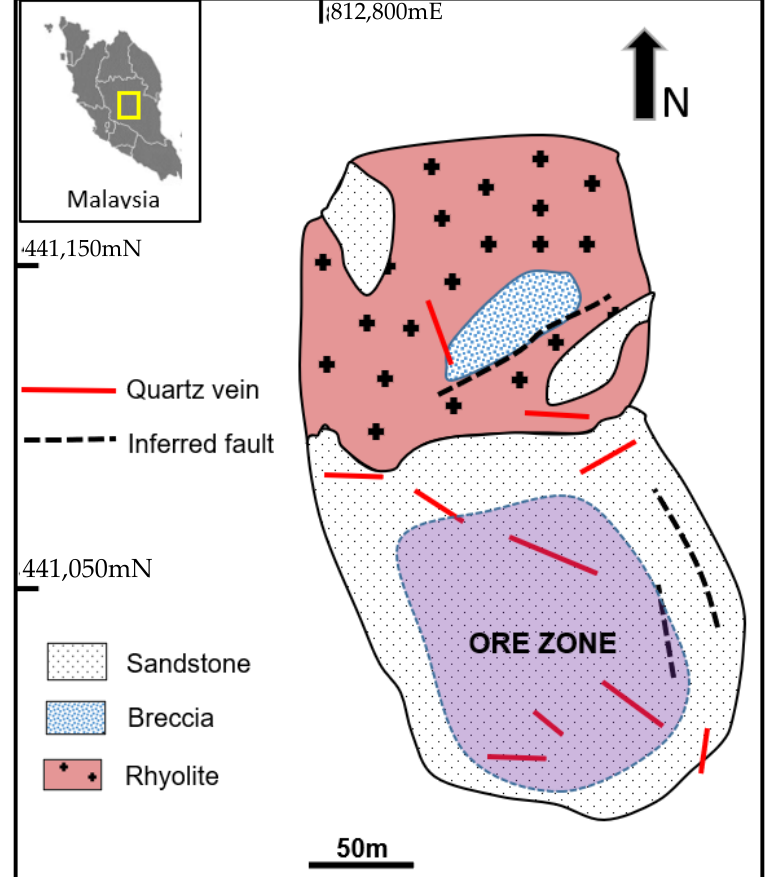
Figure 4. Geological map of the Tersang gold deposit (Modified from [3]).